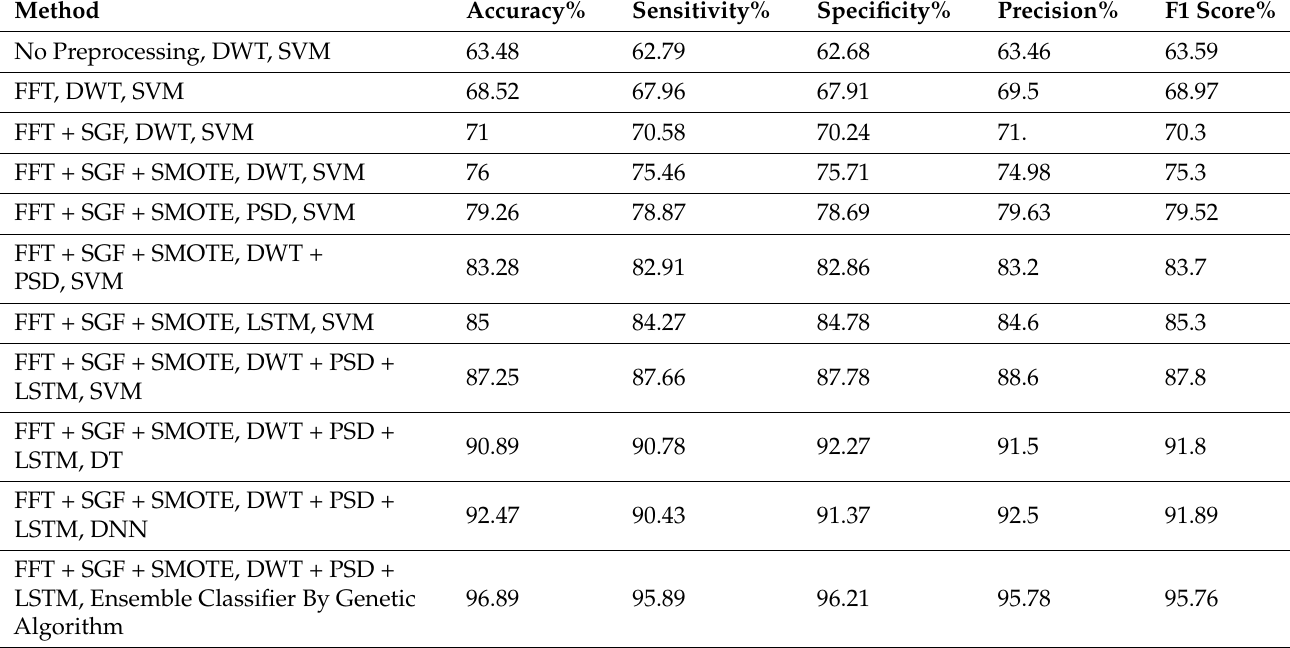
Table 6. Comparison of different experimental settings applied.